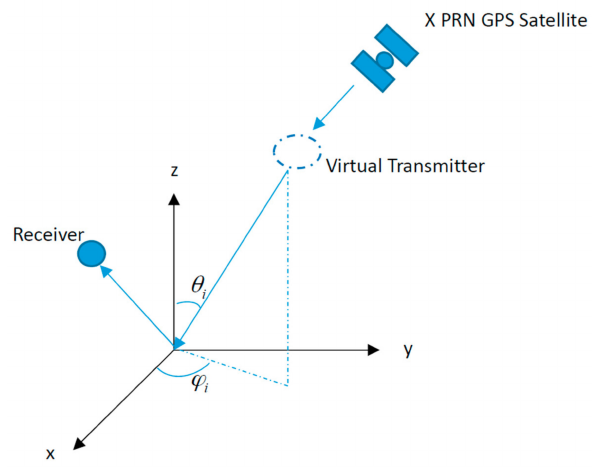
Figure 4. Illustration of virtual bistatic radar by the receiver and virtual transmitter. At any time, one or more GPS satellites (X PRN: X presents the temporal PRN number) will fall into the position of virtual transmitter with the incident azimuth and zenith angles θ i and ϕ i ,